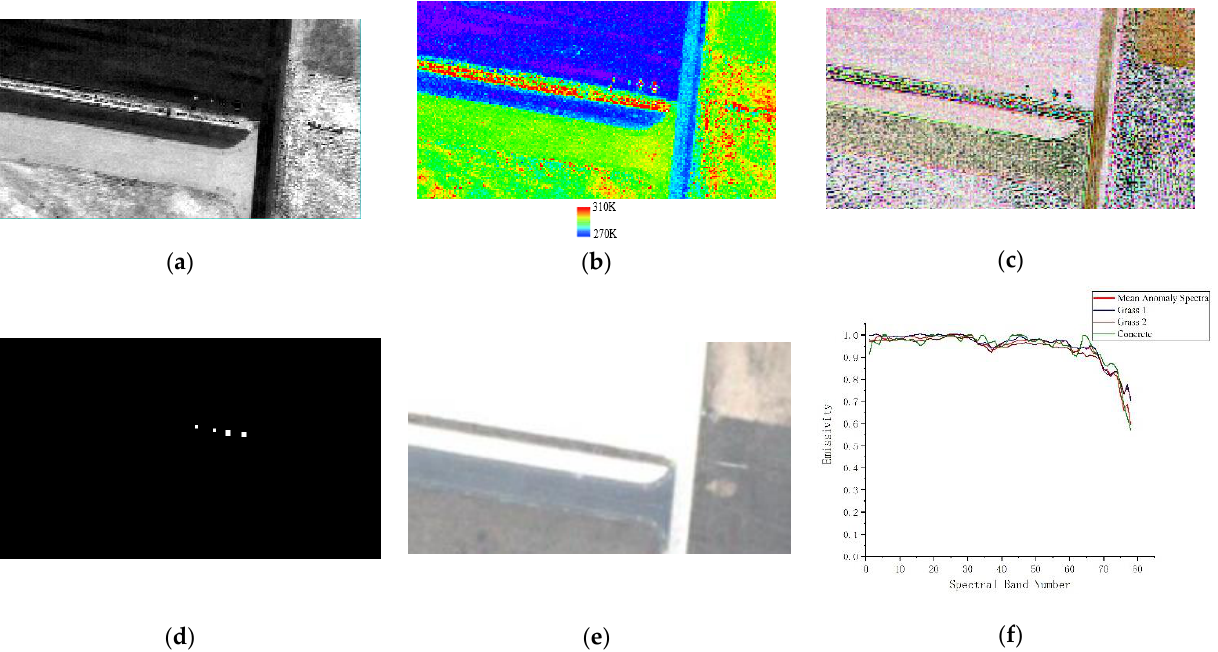
Figure 6. Metal plate data set. ( a ) Radiance domain; ( b ) temperature image; ( c ) emissivity RGB pseudo-color image synthesized by band 8, 11, 25; ( d ) ground-truth map; ( e ) RGB image; and ( f ) emissivity spectral signatures of anomalies and background.